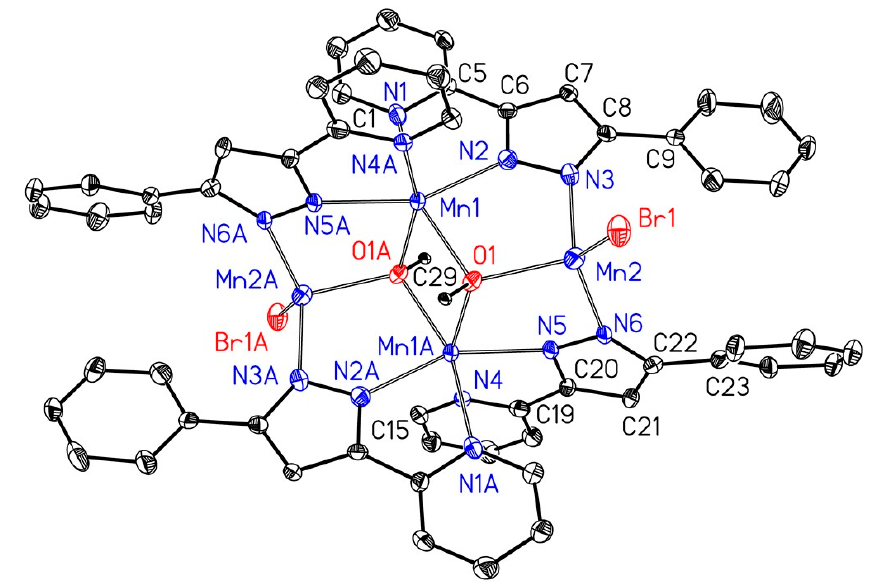
Figure 3. Molecular structure and numbering scheme of [Mn 4 (Br) 2 (µ 3 -OMe) 2 (2-PyPz Ph ) 4 ] ( 3a ). The ellipsoids represent a probability of 30%, H atoms are neglected for clarity reasons.